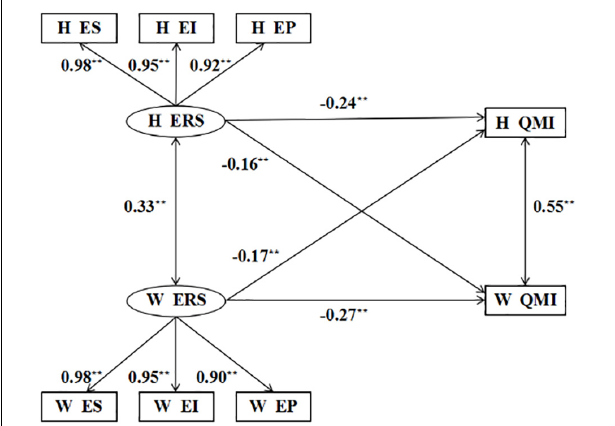
FIGURE 2 | Actor-partner interdependence model. H, husbands; W, wives; ERS, emotion reactivity scale; ES, emotion sensitivity; EI, emotion